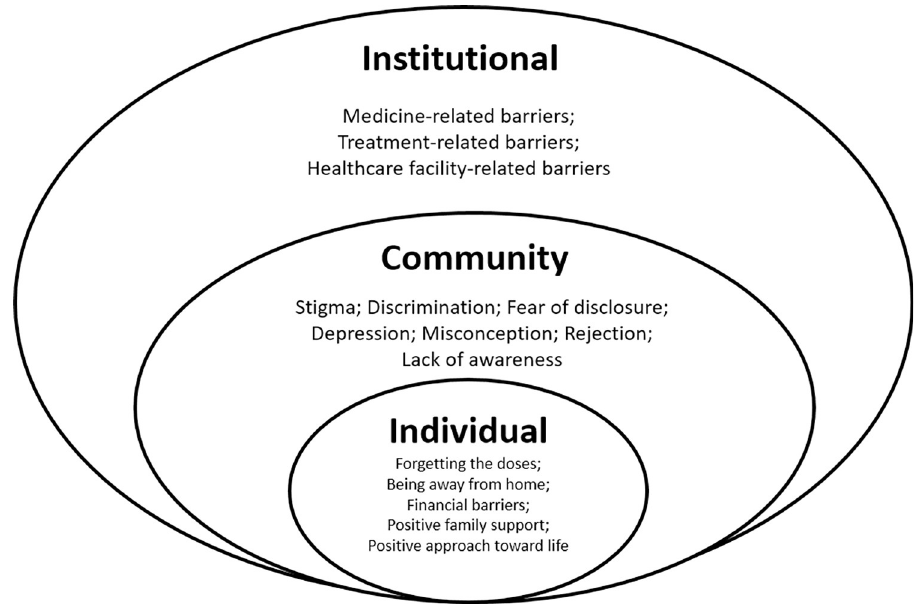
Fig 1. Thematic framework according to the socio-ecological